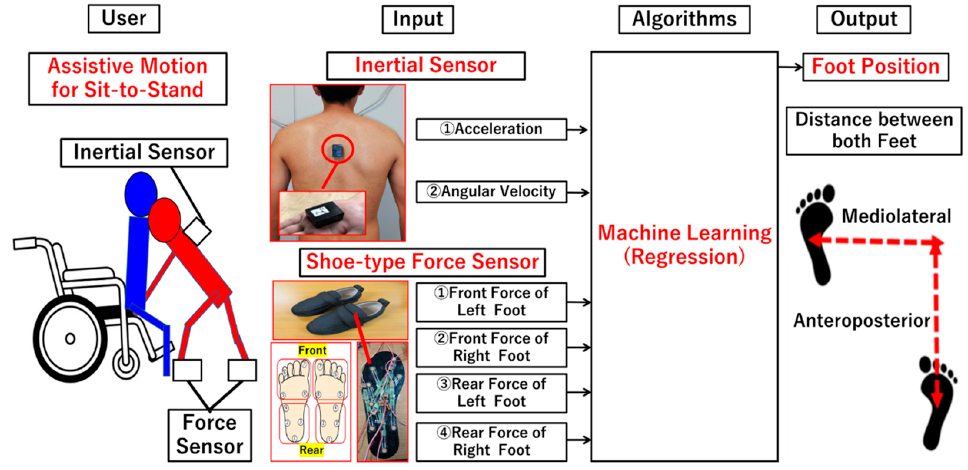
Figure 1. Architecture of the proposed method.